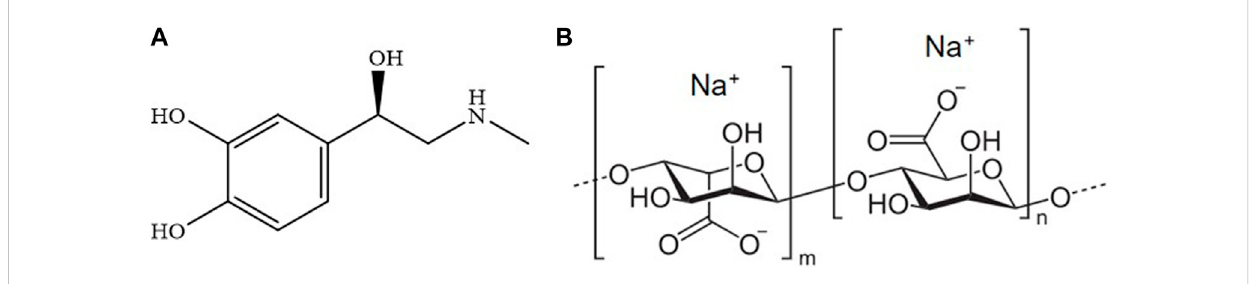
FIGURE 1 Molecular structures of epinephrine (A) and sodium alginate (B)